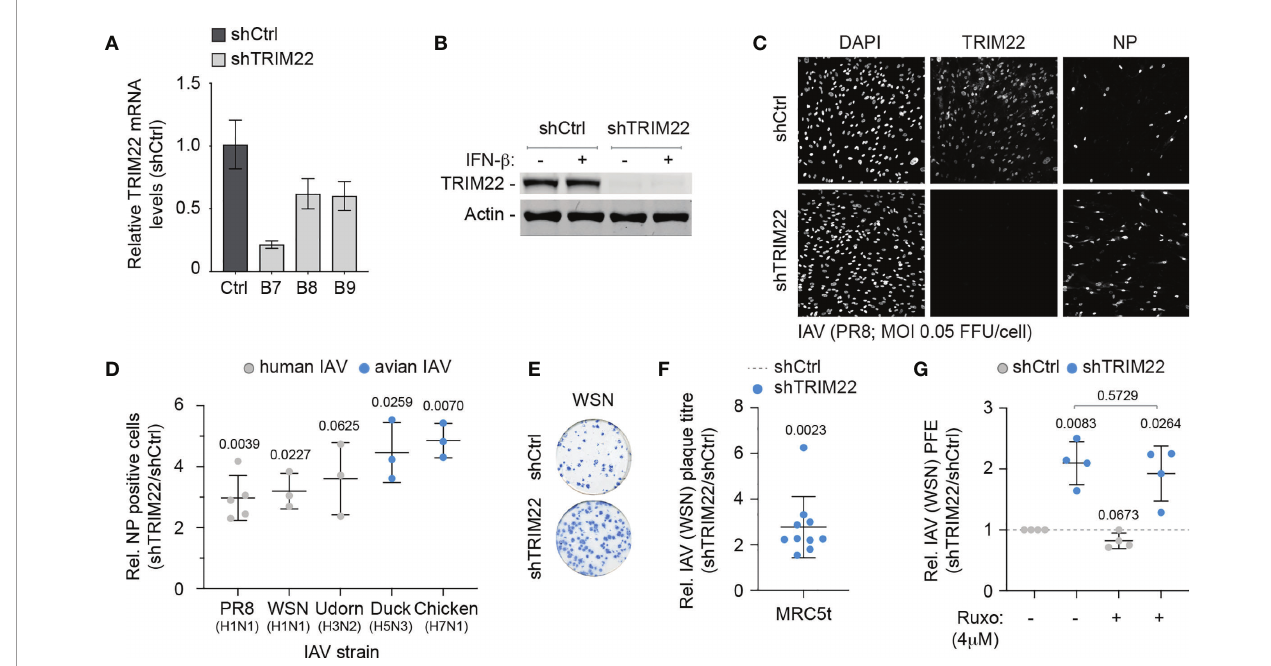
FIGURE 4 | Constitutive TRIM22 expression confers pre-existing antiviral immunity. MRC5t cells were stably transduced to express non-targeting control (shCtrl) or TRIM22-targeting (shTRIM22) shRNAs (clones B7 to B9). (A) qRT-PCR quantitation of TRIM22 mRNA levels in MRC5t shCtrl and shTRIM22 cells. Values normalized to shCtrl; n=3, means and SD shown. (B) MRC5t shCtrl and shTRIM22 (B7) cells were treated with (+) or without (-) IFN- b (100 IU/ml) for 24 h. WCLs were analysed by western blotting for TRIM22 expression. Actin is shown as a loading control. (C, D) MRC5t shCtrl or shTRIM22 (B7) cells were infected with a panel of human (WSN, A/Puerto Rico/8/1934(H1N1); PR8, and A/Udorn/307/1972(H3N2); Udorn) or avian (A/Duck/Singapore/5/1997(H5N3); Duck and A/Chicken/Italy/1067/1999 (H7N1); Chicken) IAVs at a MOI of 0.05 FFU/cell (based on MRC5t titres) for 8h. (C) Representative confocal micrographs of PR8 infected MRC5t shCtrl or shTRIM22 cells. TRIM22 and IAV NP were labelled by indirect immuno fl uorescence. Nuclei were DAPI stained. (D) Relative (Rel.) fold increase in the number of NP antigen positive cells (shTRIM22/shCtrl) in IAV infected MRC5t cell monolayers. n ≥ 3, all data points shown; line, mean; whisker, SD. (E) Representative immunocytochemistry images of IAV (WSN; 50-100 PFU/monolayer) plaque formation (NP staining) in MRC5t shCtrl and shTRIM22 cell monolayers. (F) Relative fold increase in IAV plaque formation ef fi ciency (PFE; shTRIM22/shCtrl) in MRC5t infected monolayers (as in E ). n ≥ 3, all data points shown; line, mean; whisker, SD. (D, F) One sample two-tailed t test against a theoretical mean of 1; p-values shown. (G) Quantitation of relative IAV (WSN) PFE (shTRIM22/shCtrl) in cell monolayers treated with Ruxolitinib (Ruxo; 4 µM) or DMSO (carrier control). Values normalized to infected shCtrl cell monolayers treated with DMSO (dotted line). All data points shown; line, mean; whisker SD. Upper, two-tailed t test; lower, one sample two-tailed t test against a theoretical mean of 1; p-values